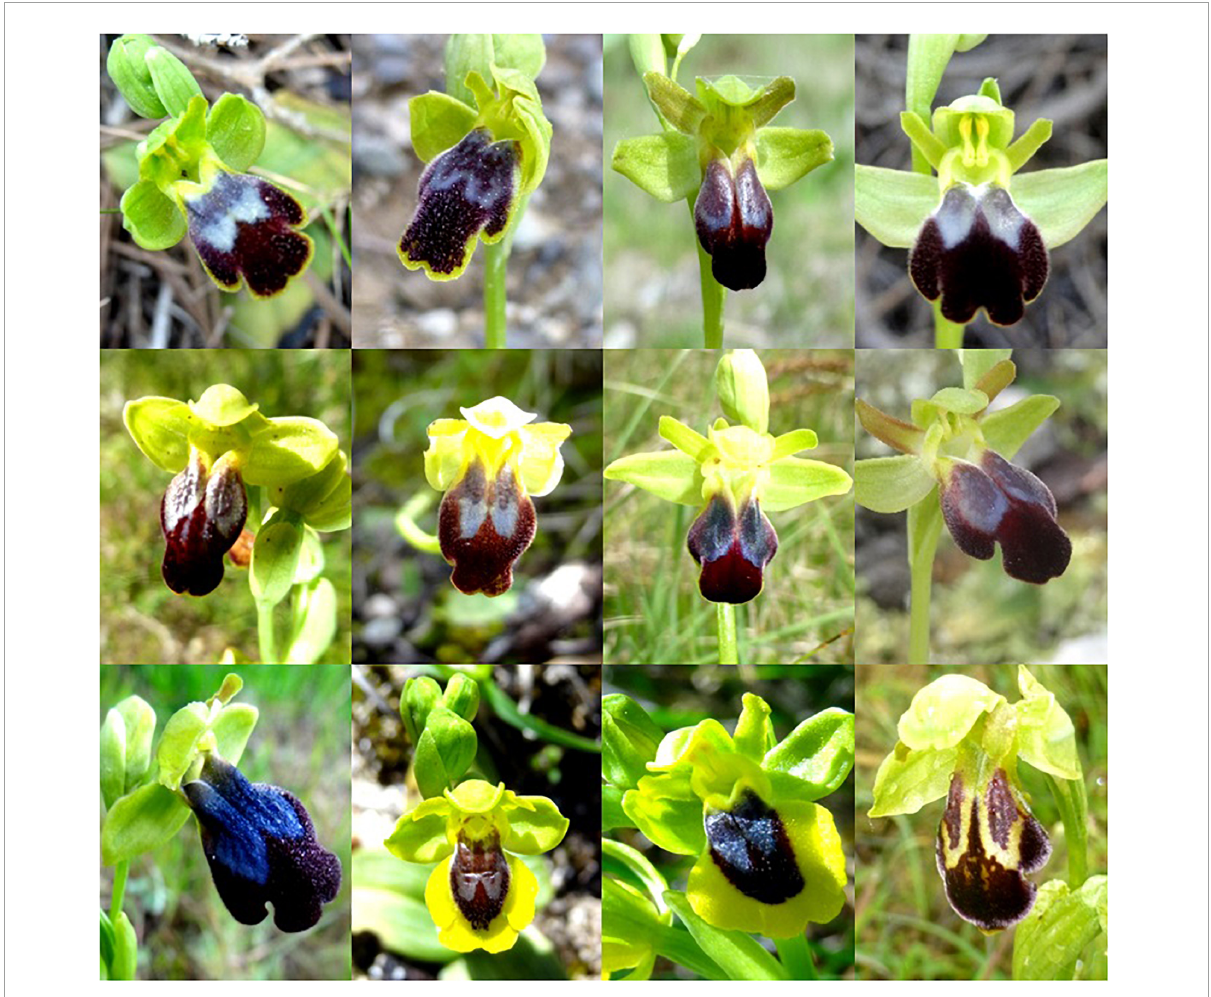
FIGURE1 Photographs of the 12 French Pseudophrys taxa sampled for molecular, morphometric, and chemical data. From left to right and top to bottom: Ophrys bilunulata, O. delforgei, O. funerea, O. lupercalis, O. marmorata, O. peraiolae, O. sulcata and O. zonata ( O. fusca group) , O. eleonorae ( O. iricolor group) , O. corsica, O. lutea ( O. lutea group) , and O. vasconica ( O. omegaifera group) . © N. Joffard and B.